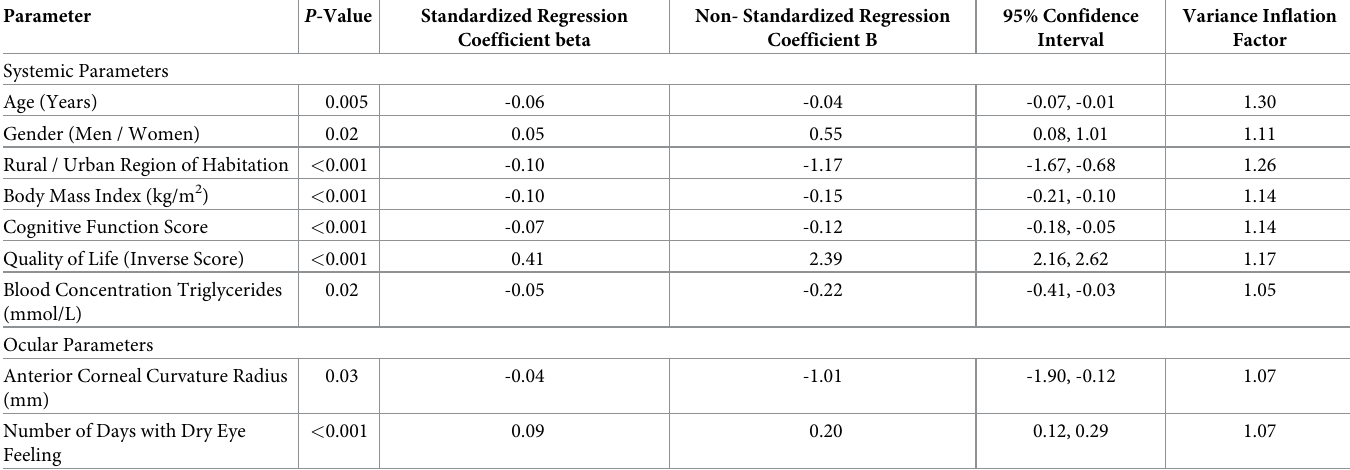
Table 3. Associations (multivariate analysis) between the self-rated depression score and systemic and ocular variables in the Beijing Eye